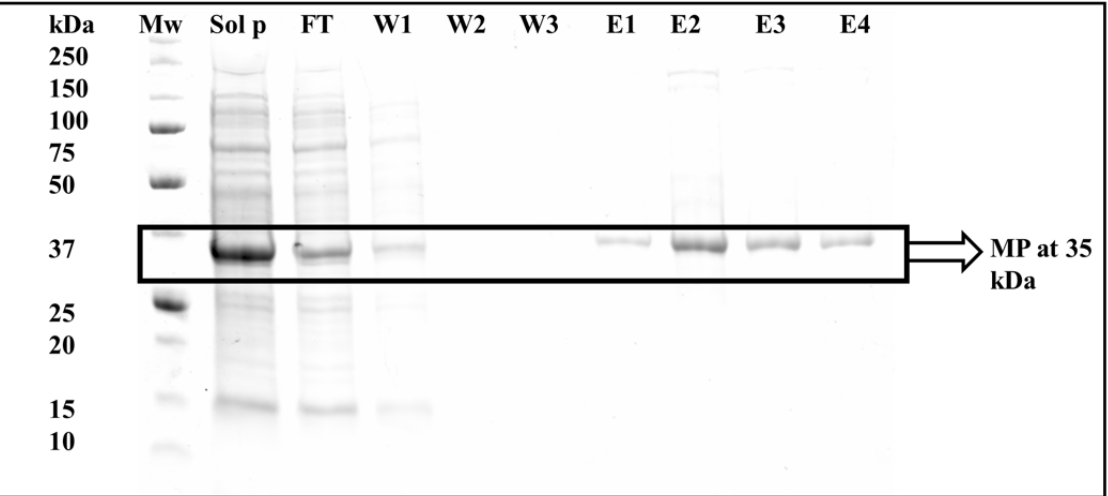
Figure 2. A 12% SDS – PAGE gel showing the elution fractions of MP from an IMAC column before refolding. Mw: unstained molecular weight marker protein standards. Lanes Sol p: protein fraction after solubilisation with 4 M urea; FT: flow-through fraction; W1: wash fraction 1; W2: wash fraction 2; W3: wash fraction 3; E1: protein elution fraction 1; E2: protein elution fraction 2; E3: protein elution fraction 3; E4: protein elution fraction 4.